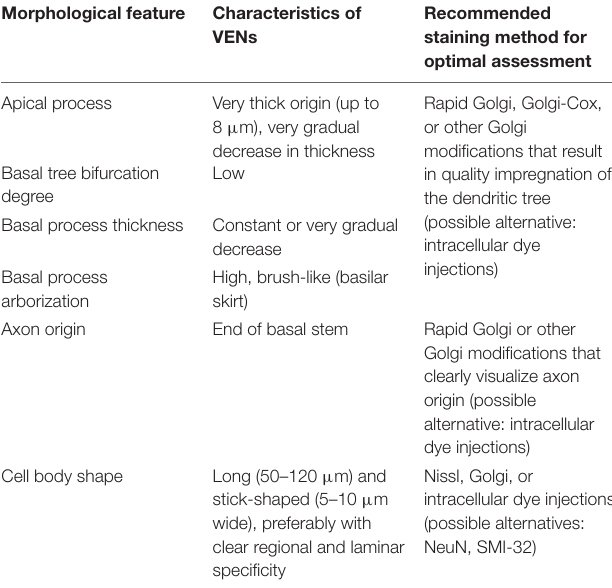
TABLE 4 | Morphological criteria for identifying VENs (adapted and modified from Banovac et al., 2019). Morphological feature Characteristics of Recommended VENs staining method for